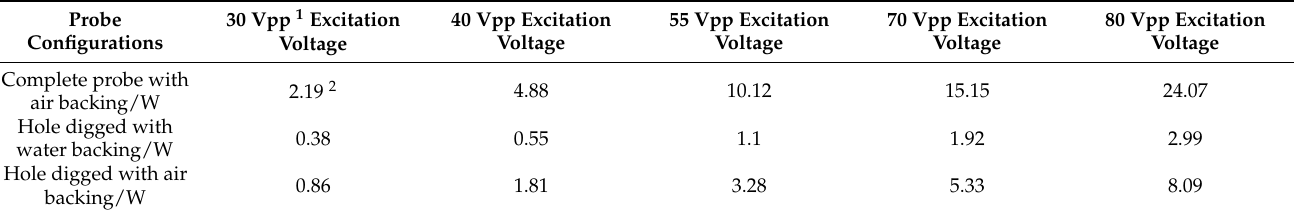
Table 1. The excitation sound power of 4.5 MHz probes with different configurations.